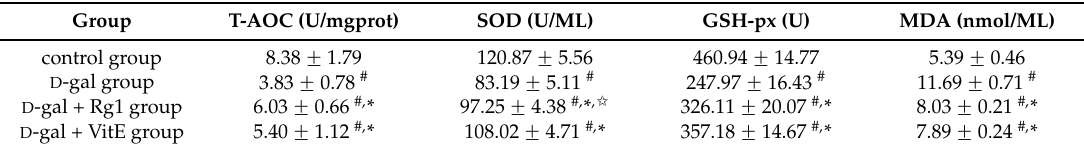
Table 1. The levels of T-AOC, SOD, GSH-px and MDA in different mouse models (mean ± SD, n = 5, # p < 0.05 vs. the control group, * p < 0.05 vs. the D -gal model group, ☆ p < 0.05 vs. the D -gal + VitE group).